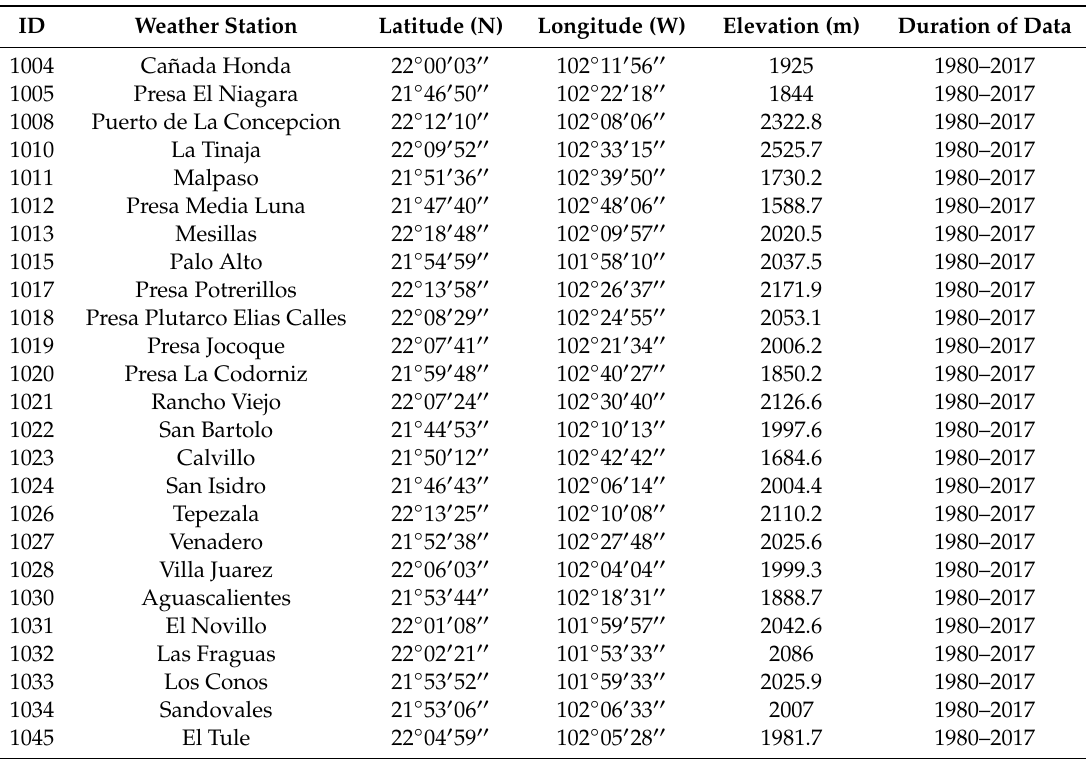
Figure 1. Location of Aguascalientes state in Mexico ( a ), spatial distribution of 36 weather stations ( b ) and land-use change for three years ( c ). Table 1. Characteristics of the 36 weather stations used in the